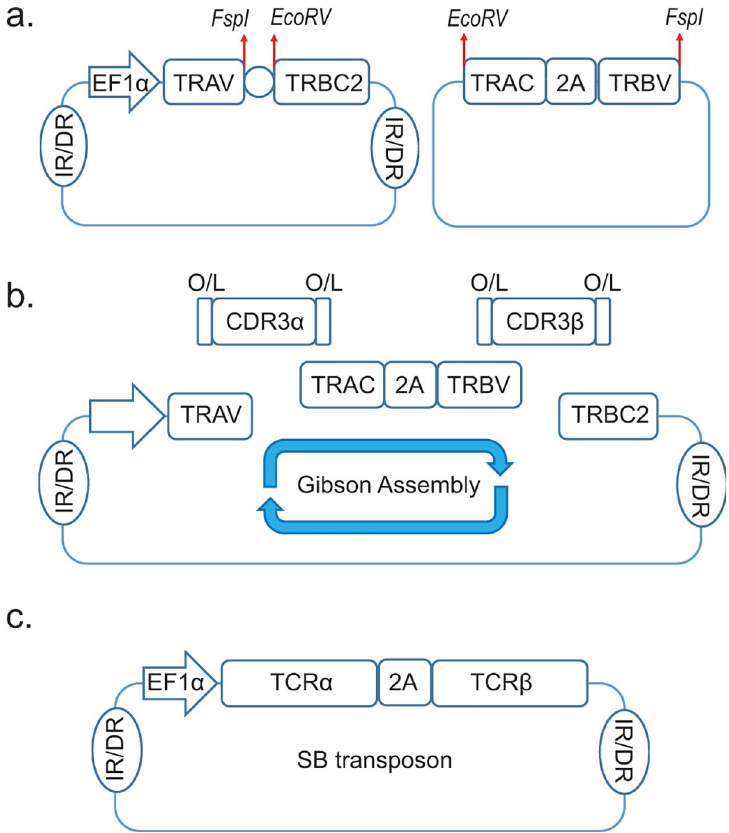
Fig 1. TCR plasmid libraries used for the rapid construction of the TCR αβ gene in the Sleeping Beauty system. a. The plasmid maps for the TRAV-TRBC2 (left) and TRAC-TRBV (right) plasmid libraries. We prepared and stored 45 TRAV-TRBC2 and 48 TRAC-TRBV plasmid libraries for the rapid construction of the TCR αβ gene. IR/DR, inverted repeats/direct repeats (a transposase binding site). b. Linearized TRAV-TRBC2 and TRAC-TRBV plasmids, along with the TCR α chain CDR3 sequence (CDR3 α ) and TCR β chain CDR3 sequence (CDR3 β ), were joined using Gibson assembly. O/L, overlap sequence (necessary for Gibson assembly). c. Isothermal 1-hour Gibson assembly resulted in a single SB DNA plasmid encoding the TCR αβ